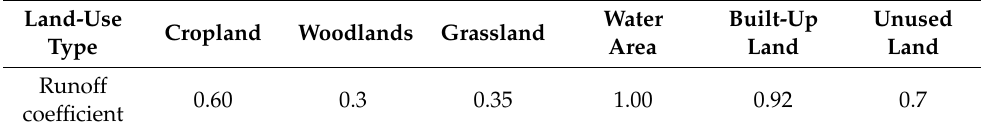
Table 2. Land-use type and the corresponding runoff